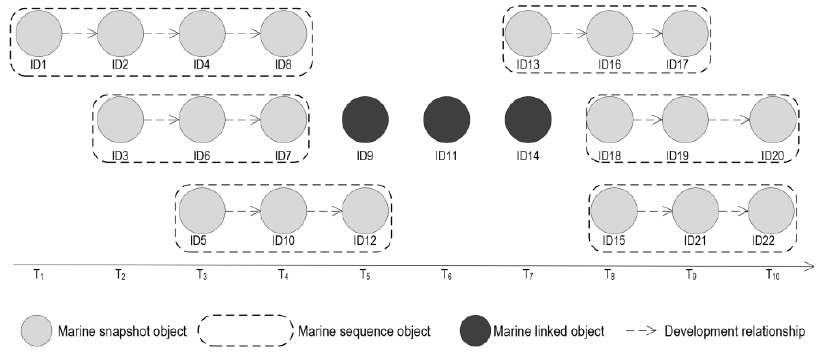
Figure 1. The marine evolutionary process, including marine sequence objects, marine snapshot objects, marine linked objects, and the development relationships within sequence objects.